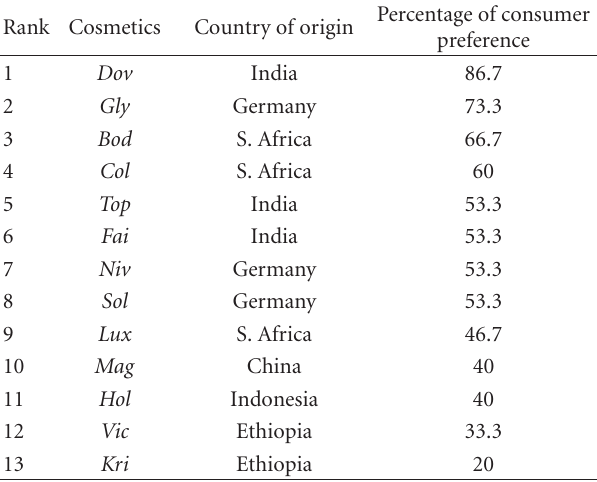
Table 2: Most commonly used cosmetic products by consumers and preference ranks given by shopkeepers in Jimma town, May, 2011. Cosmetics are listed using their abbreviations used in the result section.